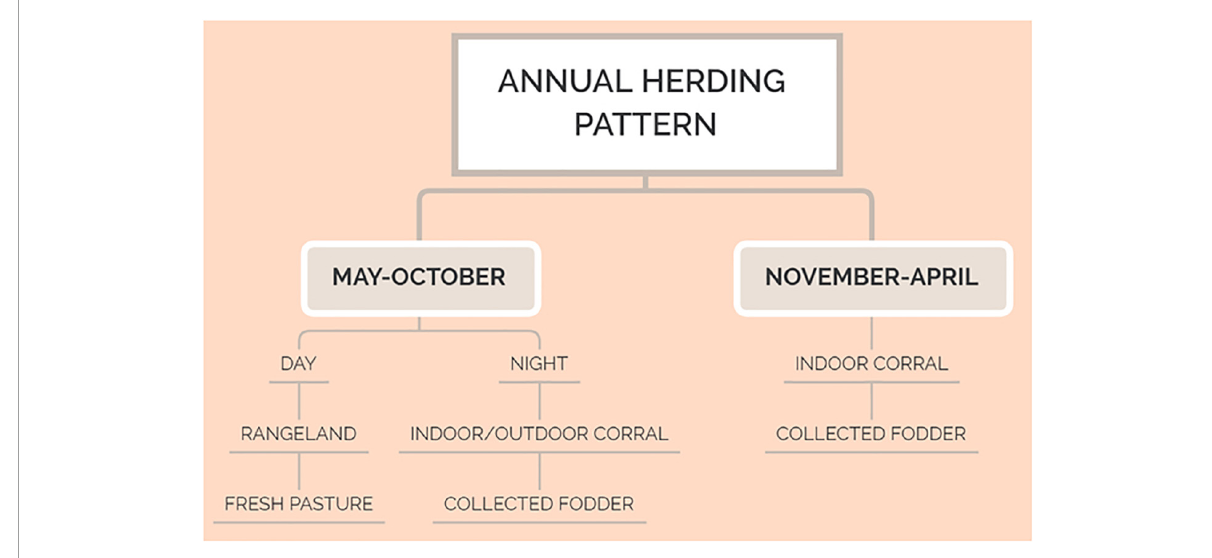
FIGURE4 The general annual herding pattern in the Southeastern Urals region.